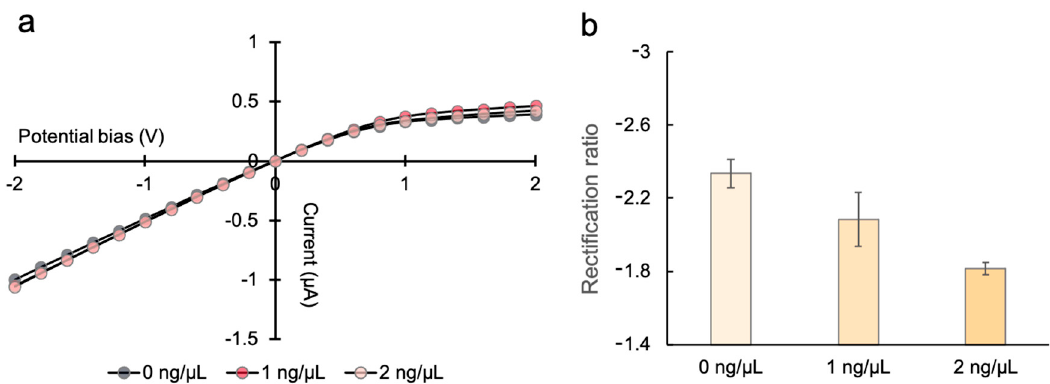
Figure 7. Electrical detection of DNA with the PHID device: ( a ) I-V curves; ( b ) corresponding rectification ratios (right, n = 3) of the representative PHID device subject to various DNA concentrations. The ionic currents were experimentally recorded at an ionic strength of 10 mM KCl.